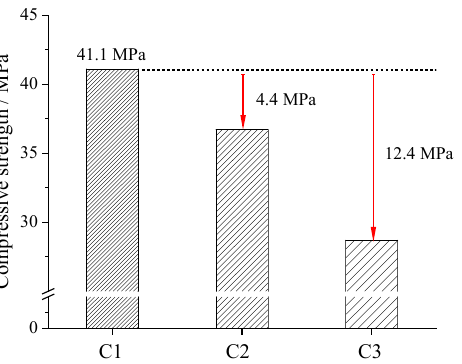
Figure 6. Compressive strength of concrete with different amount of graphite powder.